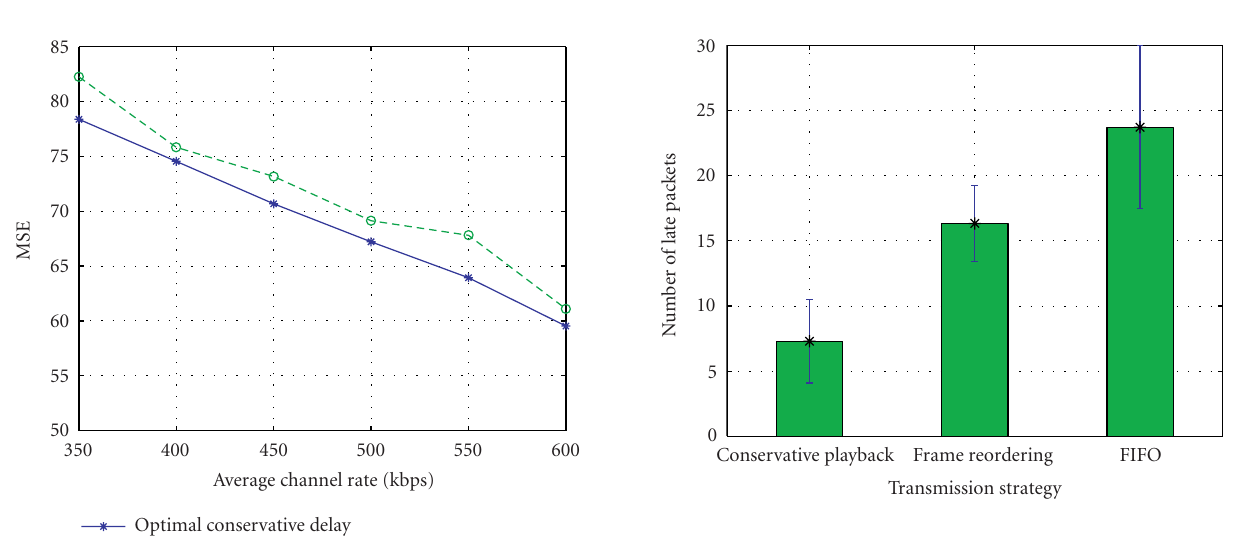
Figure 6: Late packets: conservative δ ; frame reordering; FIFO